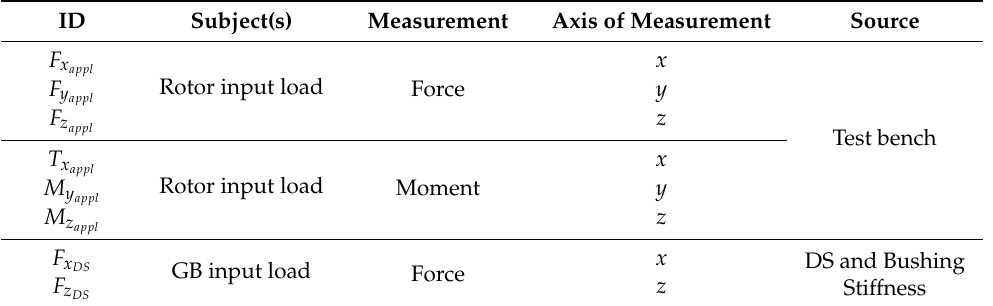
Table 2. Sources for the validation of loads.